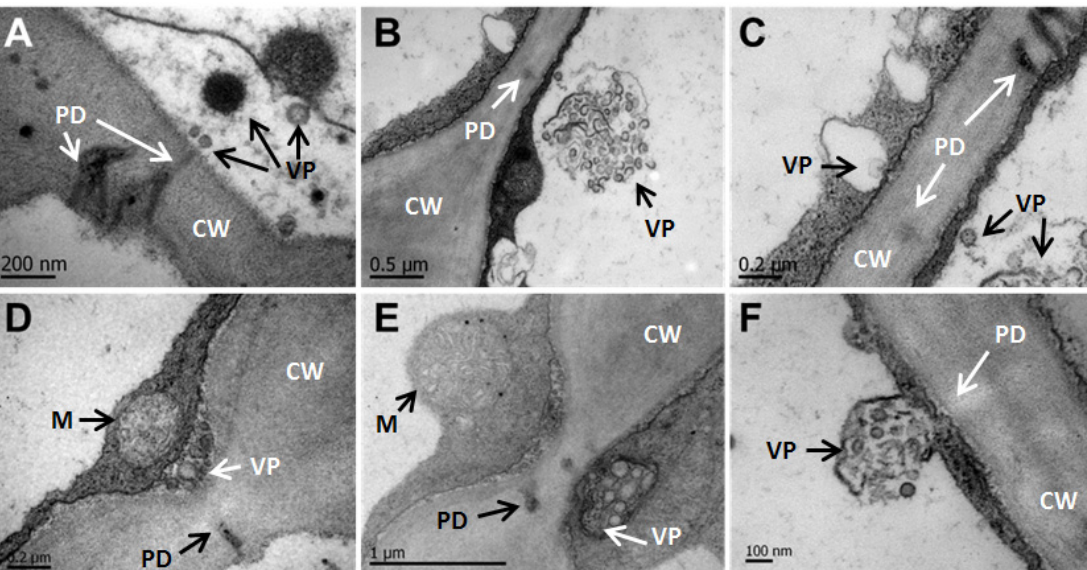
Figure 6. CNSV particles are associated with cell-to-cell interconnecting plasmodesmata. ( A – F ) Viroplasms (VP) and unassembled virions localize to secondary plasmodesmata (PD). Specialized membranous sacs show virus assembly-disassembly ( C ). Thinner cell walls (CW) with PD and viral particles (VP) are shown in ( D , E ). A disassembled viroplasm appears in close association with PD ( F ). M, mitochondria, CW, cell wall. The bar size is indicated in each